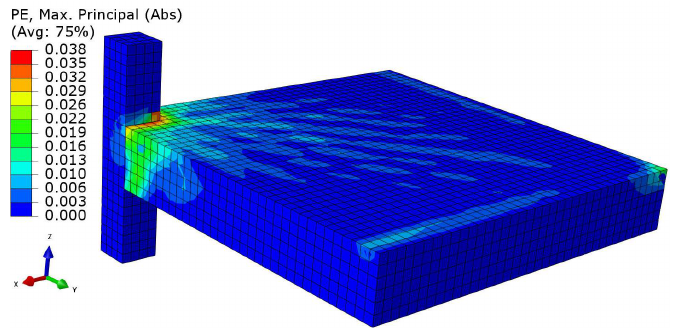
Figure 7. Tensile side of concrete slab at failure.